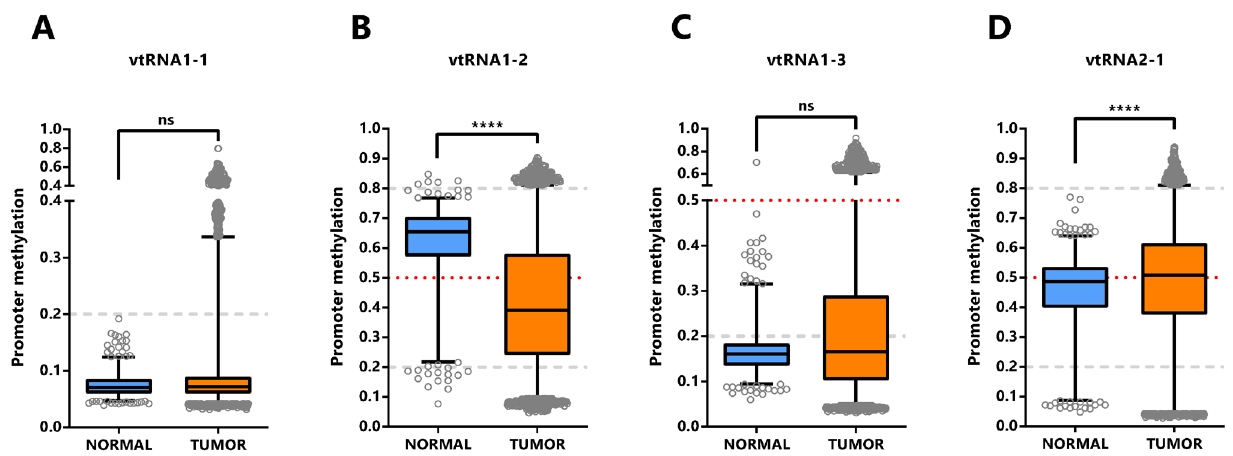
Figure 5. Promoter DNA methylation of vtRNAs in Normal and Tumor tissues of Pan-Cancer TCGA dataset. Average beta-values of promoter DNA methylation of vtRNA1-1 ( A ), vtRNA1-2 ( B ), vtRNA1-3 ( C ) and vtRNA2-1 ( D ), assessed in 746 normal and 8403 tumor tissues respectively. The box plots show the median line and lower and upper quartile and the whiskers the 2.5 and 97.5 percentile. Horizontal grey striped and red dotted lines denote unmethylated (average beta-value ≤ 0.2), 50% methylated (average beta-value = 0.5) and highly methylated (average beta-value ≥ 0.8) promoters. One-way ANOVA multiple test analysis with Sidak as posthoc test was performed. **** p-value <